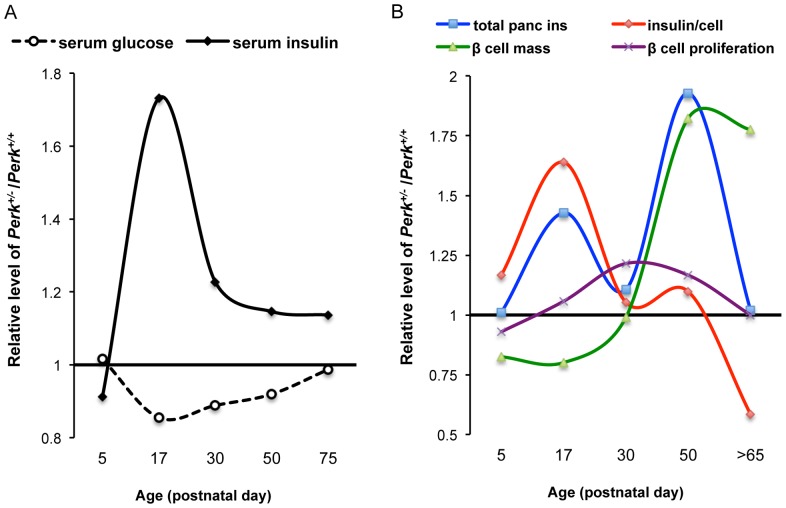
Developmental summary and model of PERK-dependent regulation of β-cell development and glucose homeostasis.A. Genotypic difference of serum glucose and insulin throughout development. Figure 9A was generated based on the data in Fig 2A and Fig 2C. Serum glucose and insulin are inversely correlated during postnatal development of Perk+/− mice. B. Genotypic difference of total pancreatic insulin content (based on data in Fig 3A), insulin content per β-cell (Fig 3C), β-cell number (Fig 3D), and β-cell proliferation rate (Fig 7B). Initially β-cell number is relatively low in Perk+/−, but β-cell and total pancreatic insulin are high. In response to low β-cell number, β-cell proliferation is accelerated between postnatal 17–50 resulting in increased β-cell number in Perk+/−. However, as β-cell number rises, insulin content per β-cell drops resulting in a balance between cell number and insulin concentration in each cell and a return to equivalent levels of total pancreatic insulin content.